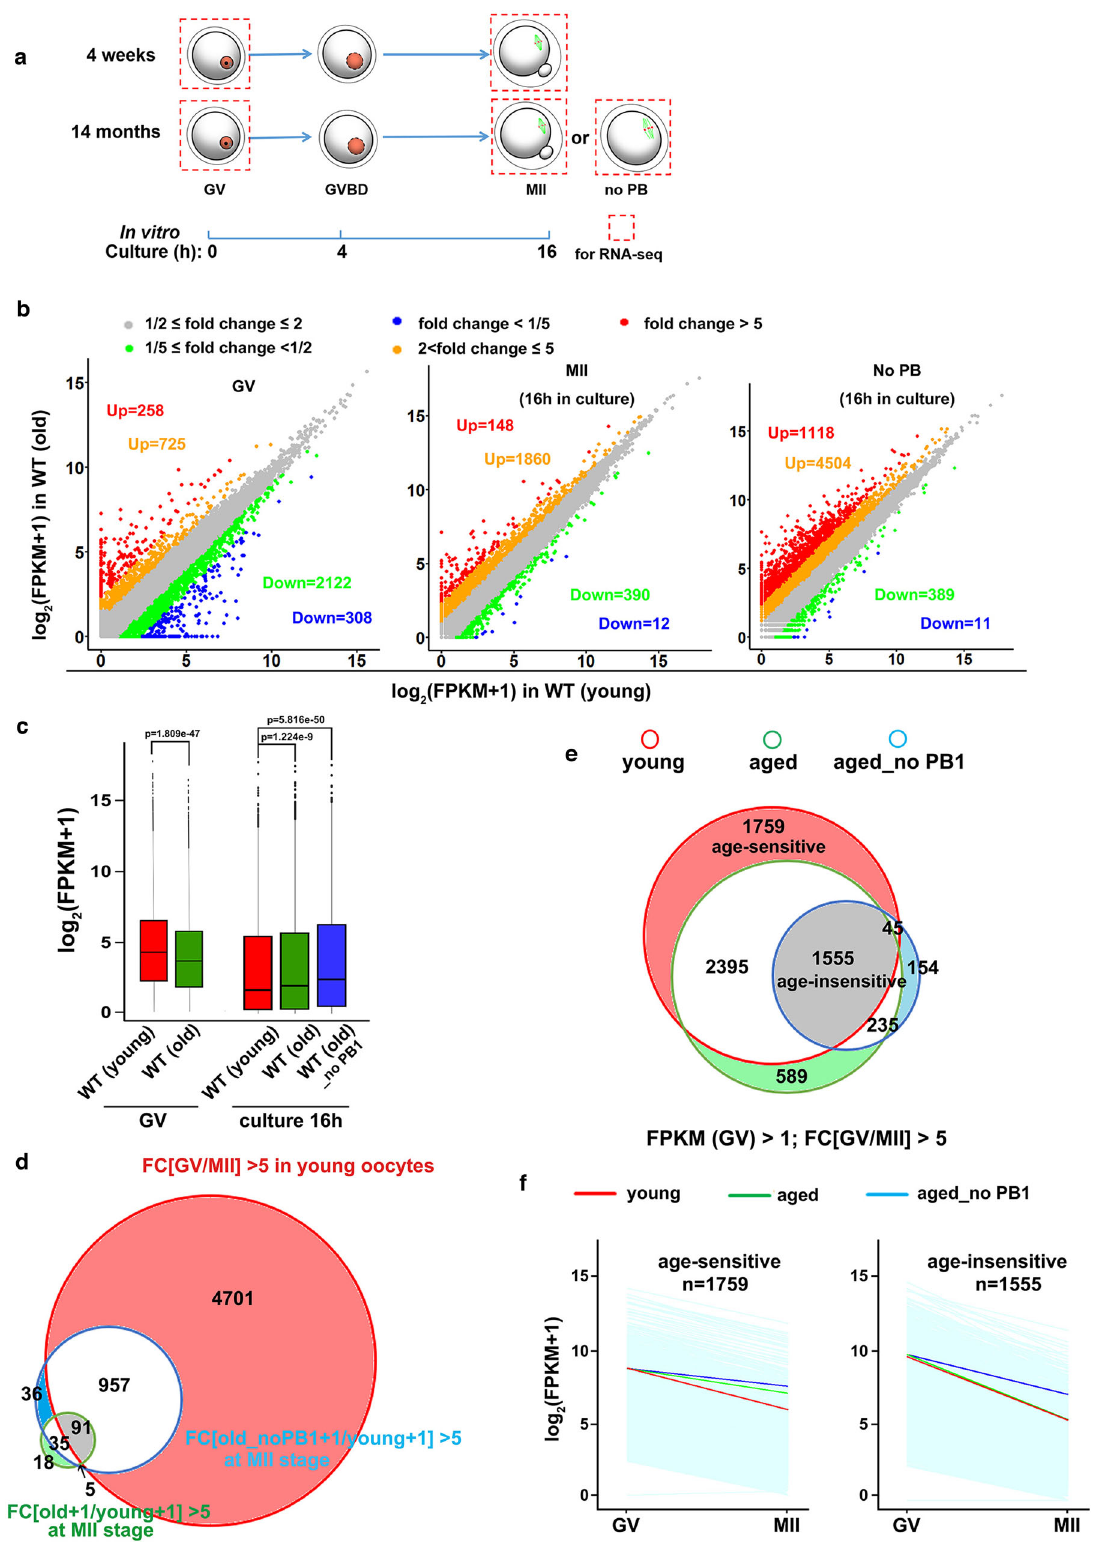
Potential involvement of histone H3 lysine-4 trimethylation in oocyte aging . In the following analyses, we investigated the potential mechanisms that cause aging-associated transcriptome changes in oocytes, i.e. downregulation of maternal mRNA tran- scription at the GV stage and impaired maternal mRNA decay